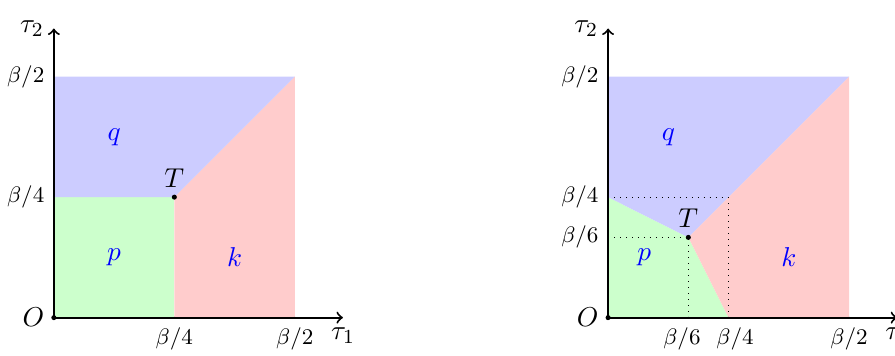
Figure 16 . Left: phase diagram near ‘ = 0. T denotes the ‘tri-critical’ point. Right: phase diagram near ‘ = 1 . T denotes the ‘tri-critical’ point. We see that it moves towards the origin. such that the two bulk particles are hidden behind the left and right horizons. Then, as opposed to (cid:12)gure 11, the extremal RT surface is outside the right and left causal wedges and has no overlap with it. This situation is shown on the right in (cid:12)gure 15. Still, following the discussion in section 4, left- or right observers with su(cid:14)cient detailed understanding of the microscopic wave function would be able to perform a one-sided bulk reconstruction of their full entanglement wedge, indicated by the green and blue regions in (cid:12)gure